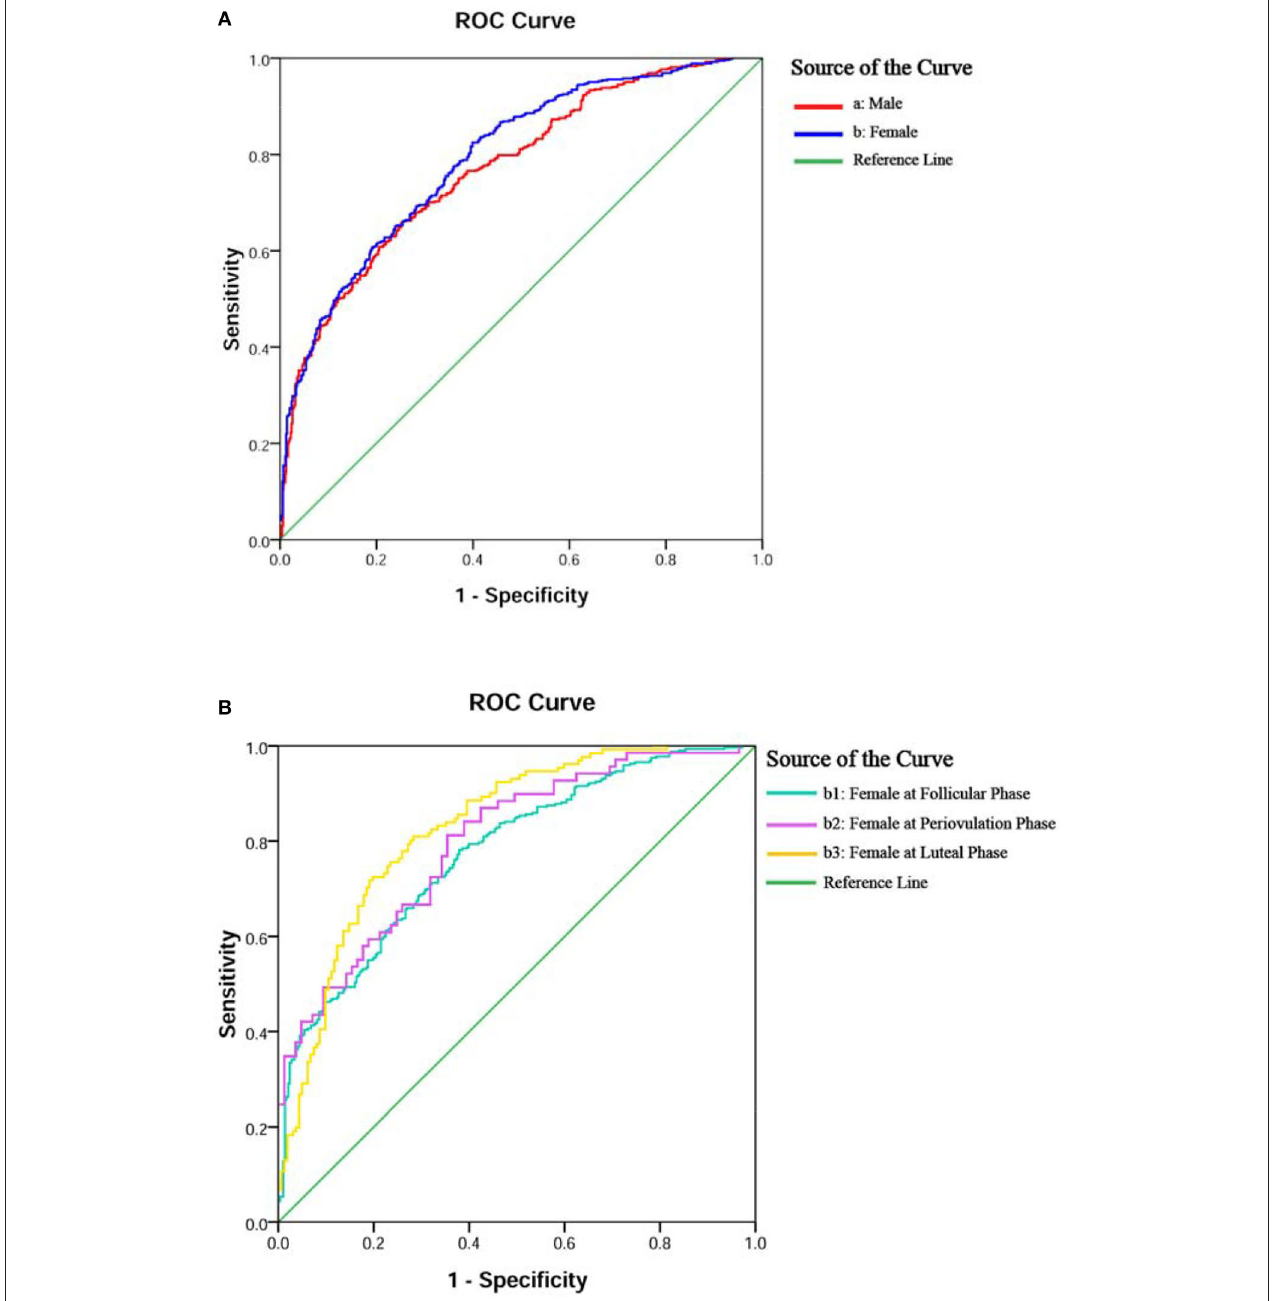
FIGURE 2 | ROC curves of the logistic regression model for diagnostic accuracy of BD or MDD. Diagnostic accuracies of the models were yielded by gender in (A,B) and female subgroups in ( B